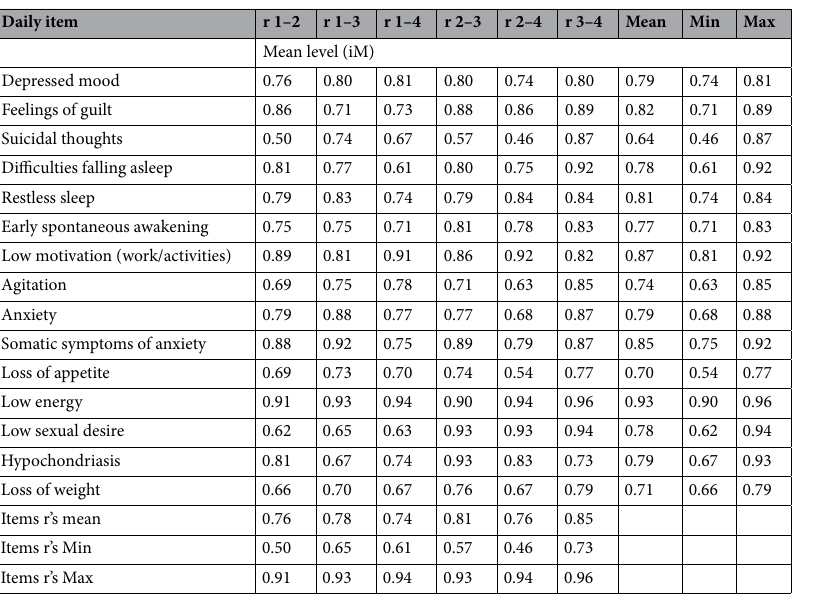
Table 5. Stability in individual level of symptoms (Mean) over 4 weeks of the assessment period. N = 50 All correlations greater than 0.36 are significant at p <